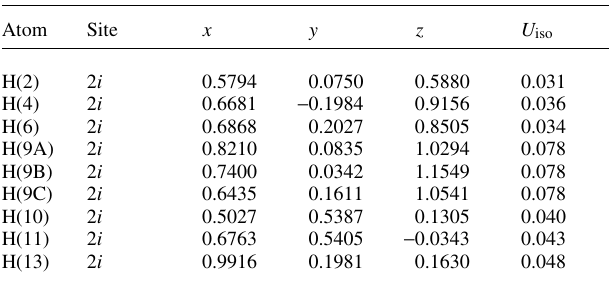
Table 2. Atomic coordinates and displacement parameters (in Å 2 )